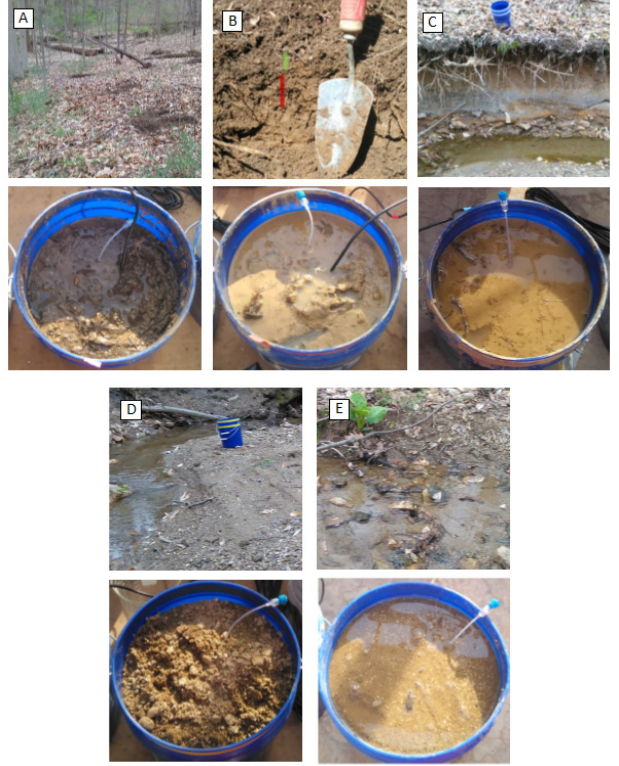
Figure 1. Watershed sources of particulate material and sediments during sampling and their place ‐ ment in buckets for mesocosm analysis. The sources included—( A ) forest floor humus; ( B ) upland mineral A horizon soil; ( C ) stream bank soil; ( D ) floodplain storm deposit; and ( E ) stream bed sed ‐ iments.